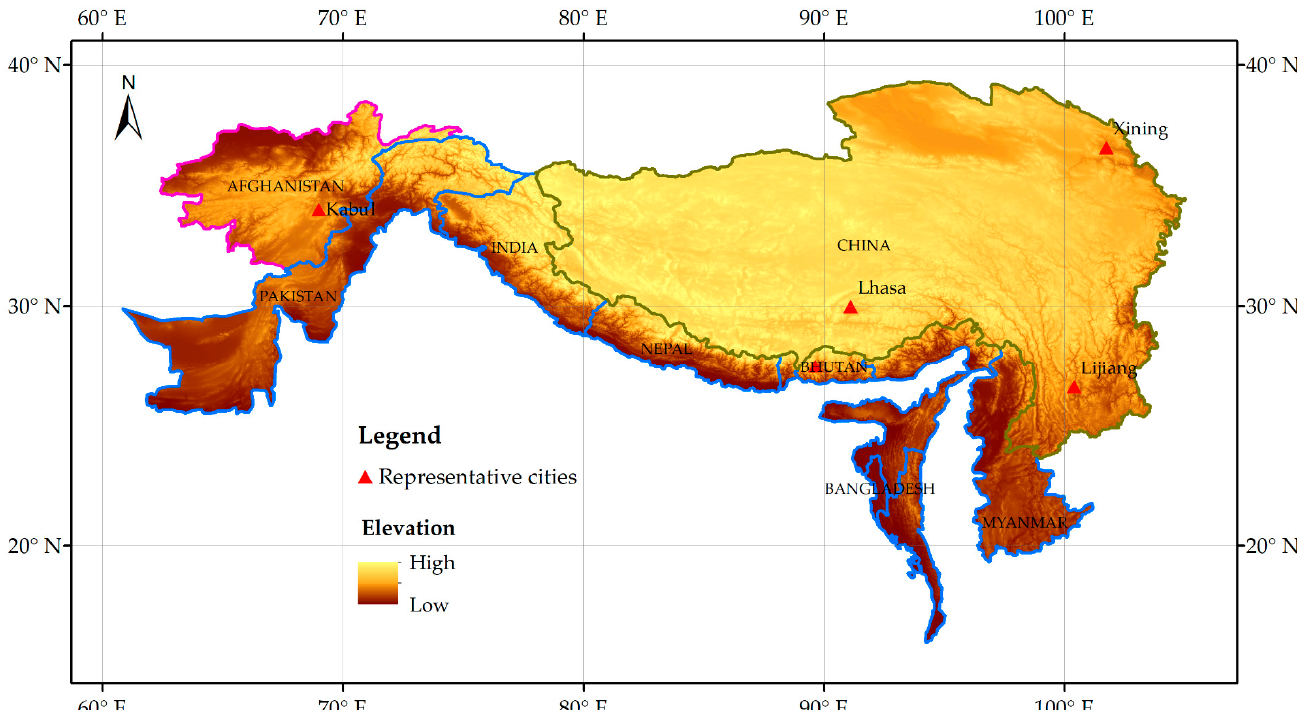
Figure 1. Map of the location of the HKH region and the selected cities used to evaluate the artificial impervious area products. (The elevation derived from GTOPO30, a global digital elevation model (DEM) with a horizontal grid spacing of 30 arc seconds from https://e4ftl01.cr.usgs.gov/MEASURES/SRTMGL1.003/2000.02.11/index.html (accessed on 15 December 2021). The region borderline with ginger pink is Afghanistan, the borderline with blue indicates the region including Pakistan, India, Nepal, India, Bhutan, India, Bangladesh, and Myanmar from the northwest to the southeast, and the region with dark olivenite refers to part of China).